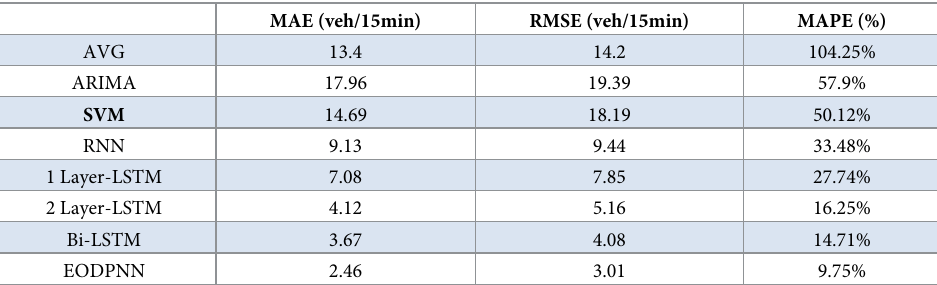
Table 2. Network performance comparison.